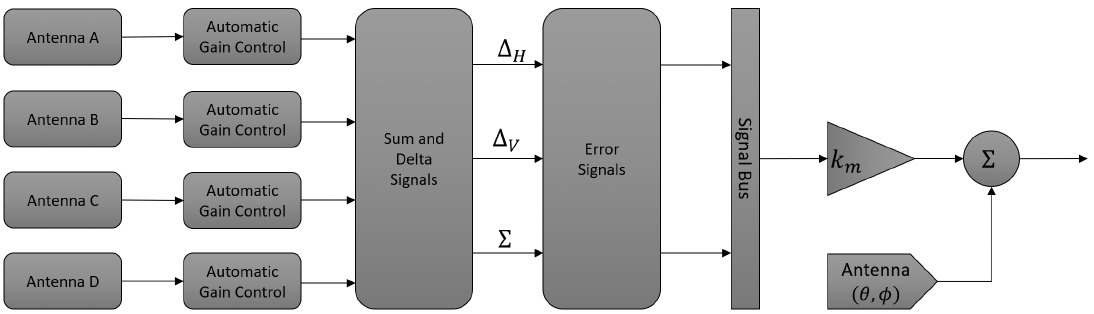
Figure 14. The monopulse receiver shown at the system level, calculates the error in the measured angle relative to the pointing angle of the